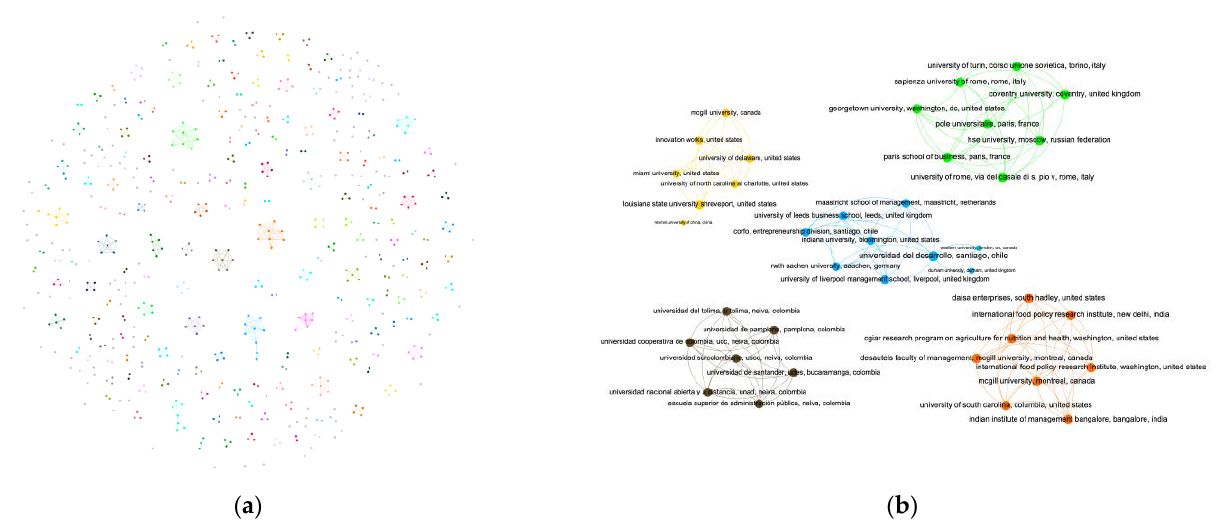
Figure 7. Co-authorship network: ( a ) the full network and ( b ) the top 5 largest clusters. Source: authors based on VOSviewer software.